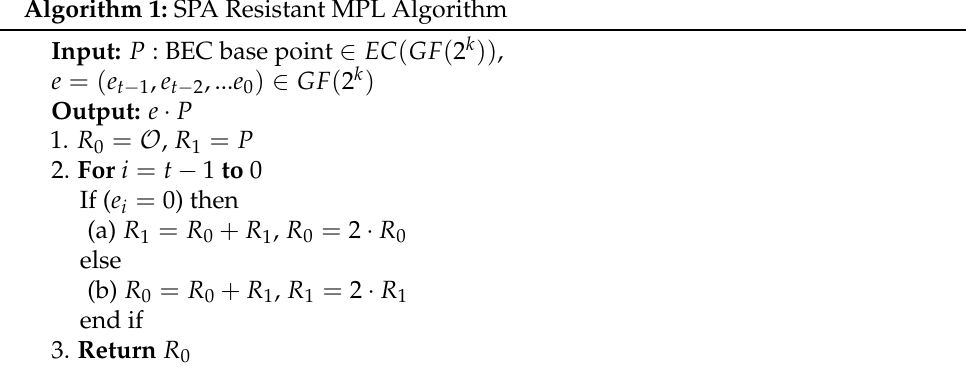
Algorithm 1: SPA Resistant MPL Algorithm